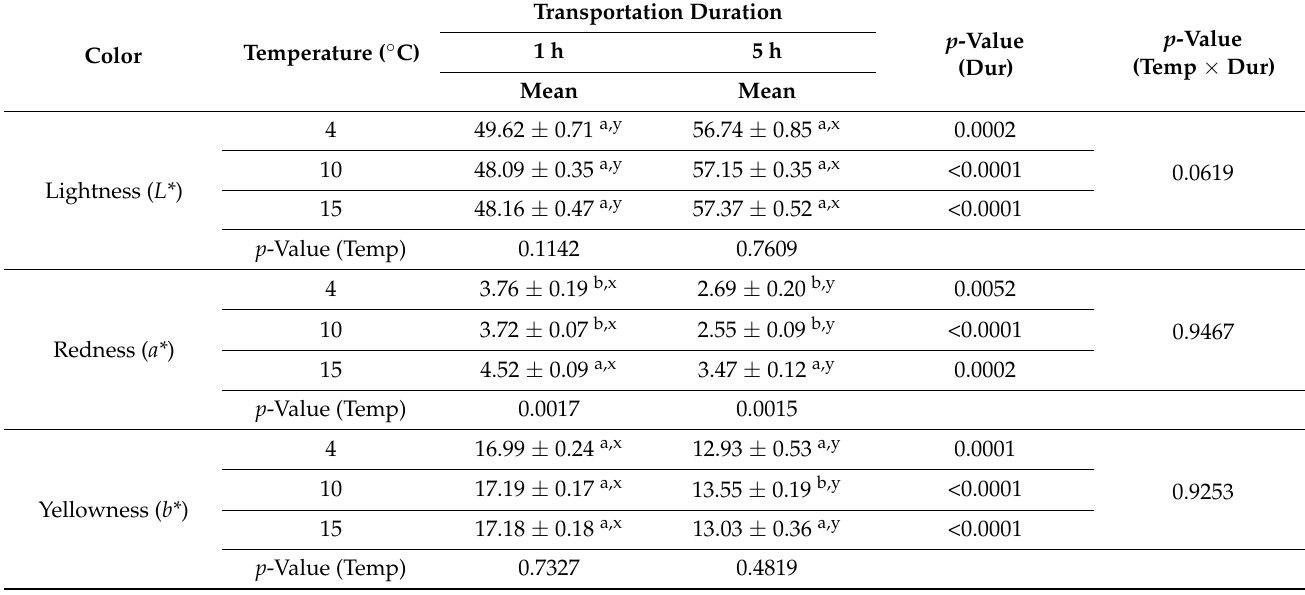
Table 3. Effects of transportation temperatures (4 ◦ C, 10 ◦ C, and 15 ◦ C) for two different transportation durations (1 and 5 h) on color characteristics (lightness ( L* ), redness ( a* ), and yellowness ( b* )) of pectoralis major muscles in broiler